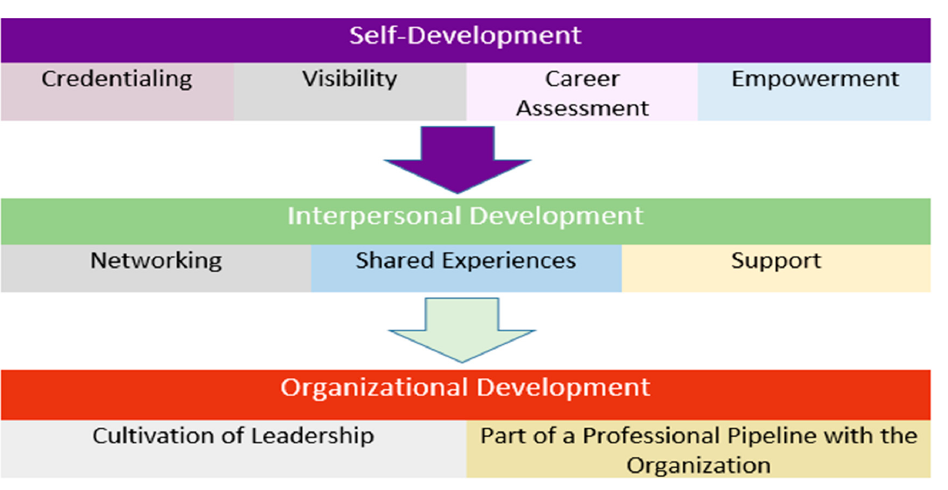
Figure 1 Themes at the Personal Development Level: Vulnerability, Structured Space for Reflection, and Being Seen and Heard.